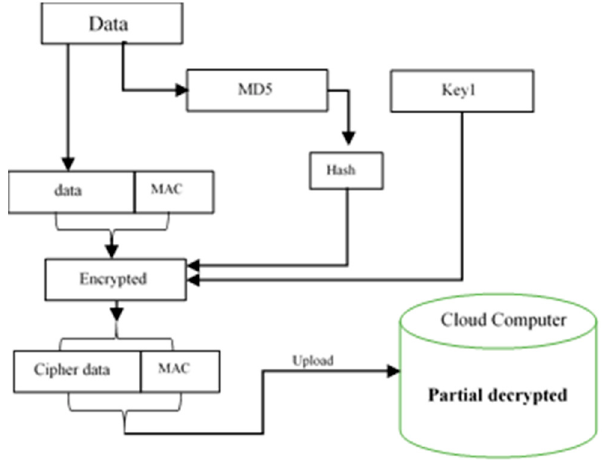
Figure 3. Encrypted and uploaded data in the proposed system.